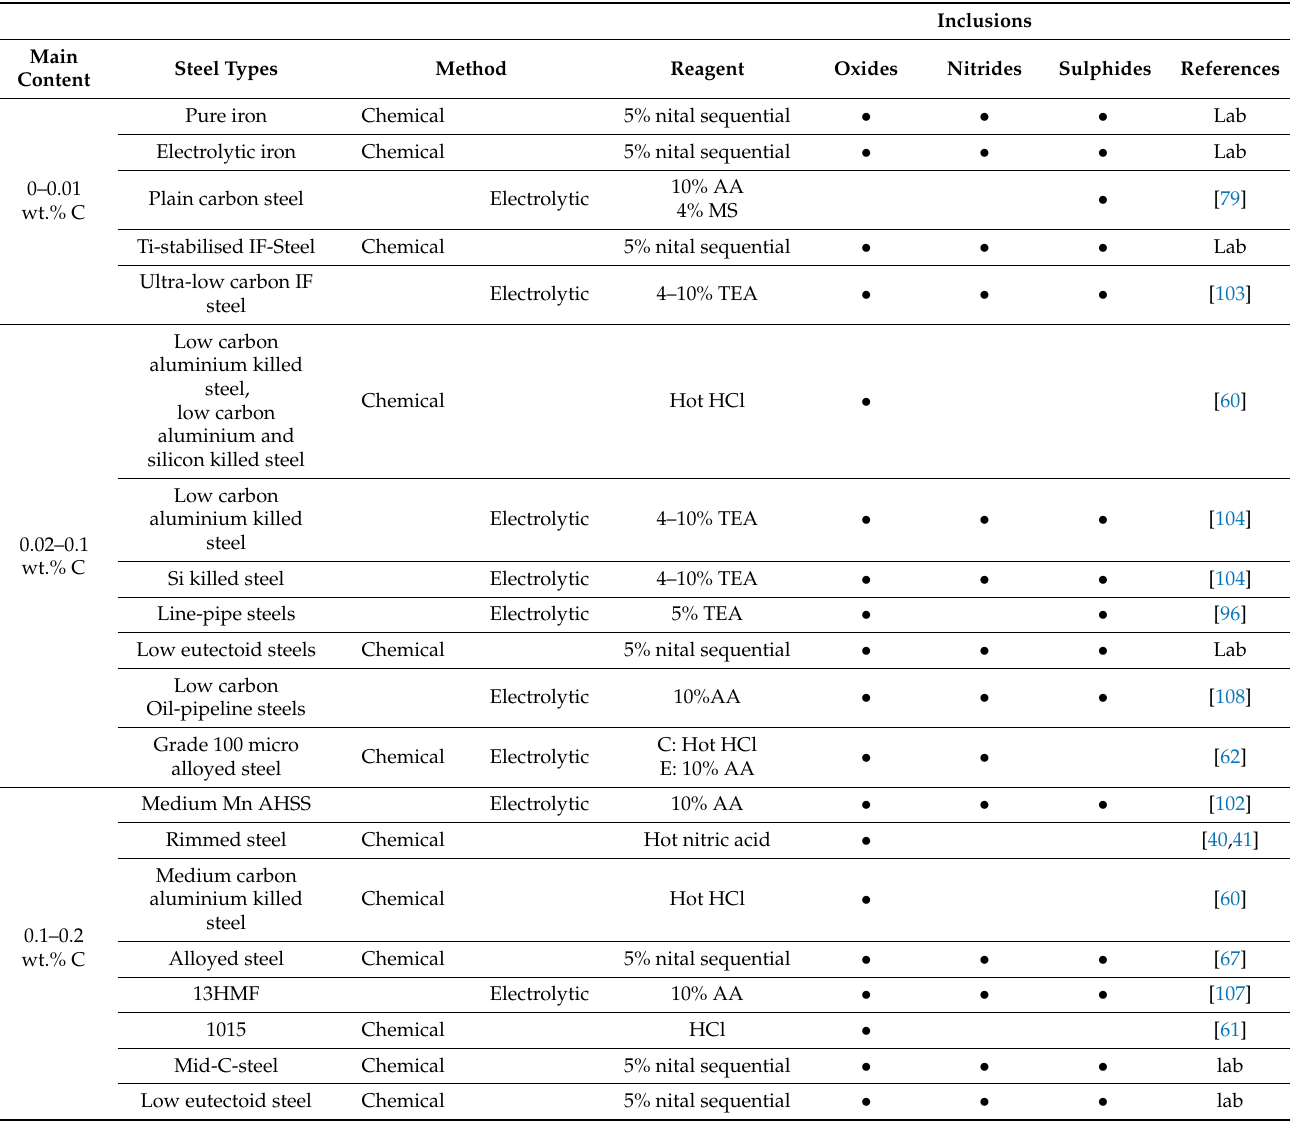
Table 1. Extraction methods after